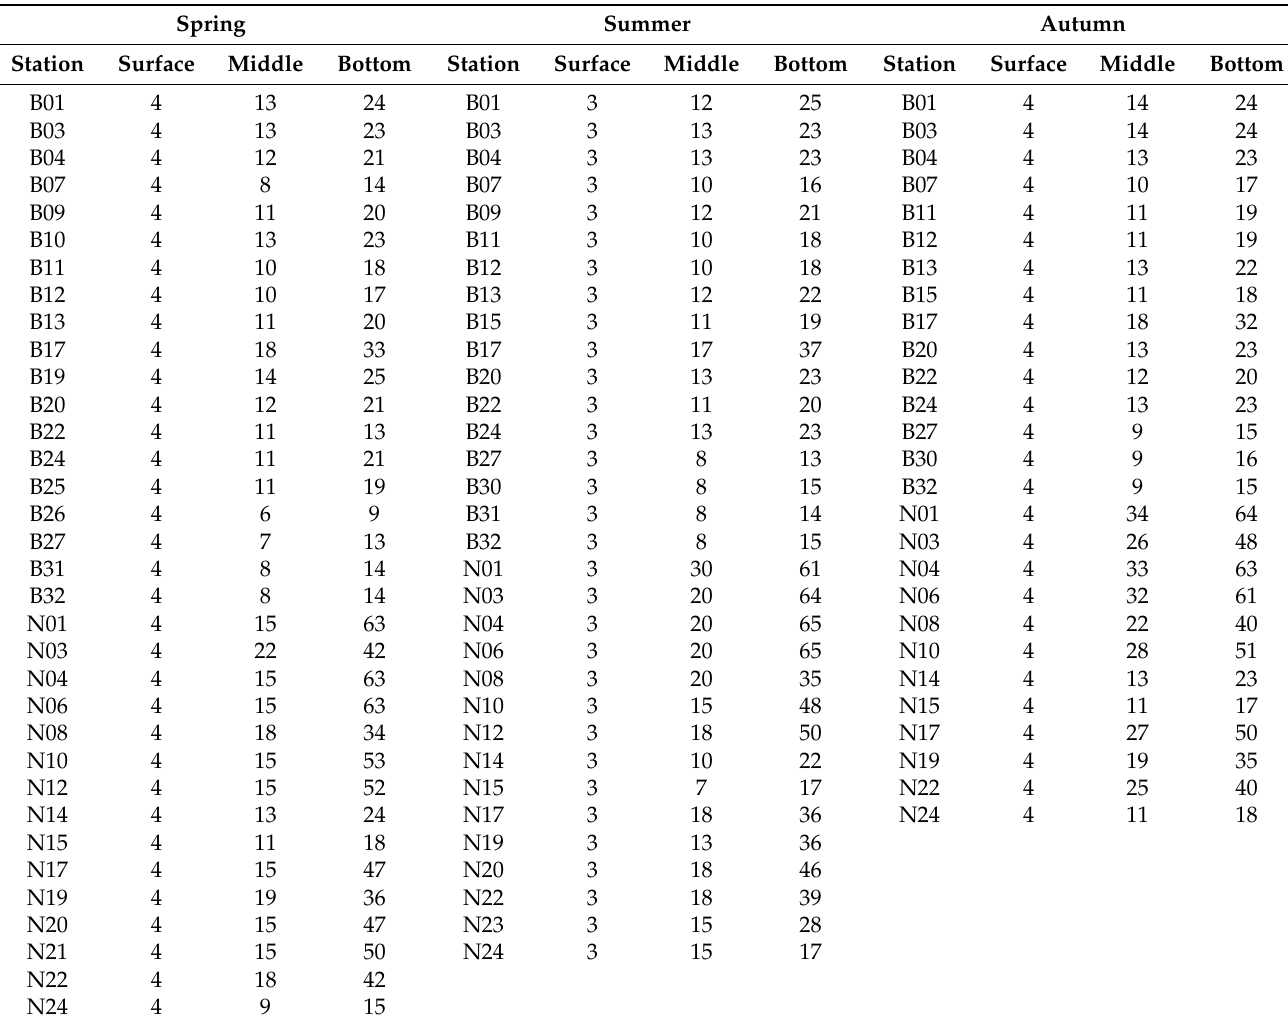
Table 1. The depth (m) of the water samples in the Bohai Sea (BS) and the North Yellow Sea (NYS) in three seasons. Spring Summer Autumn